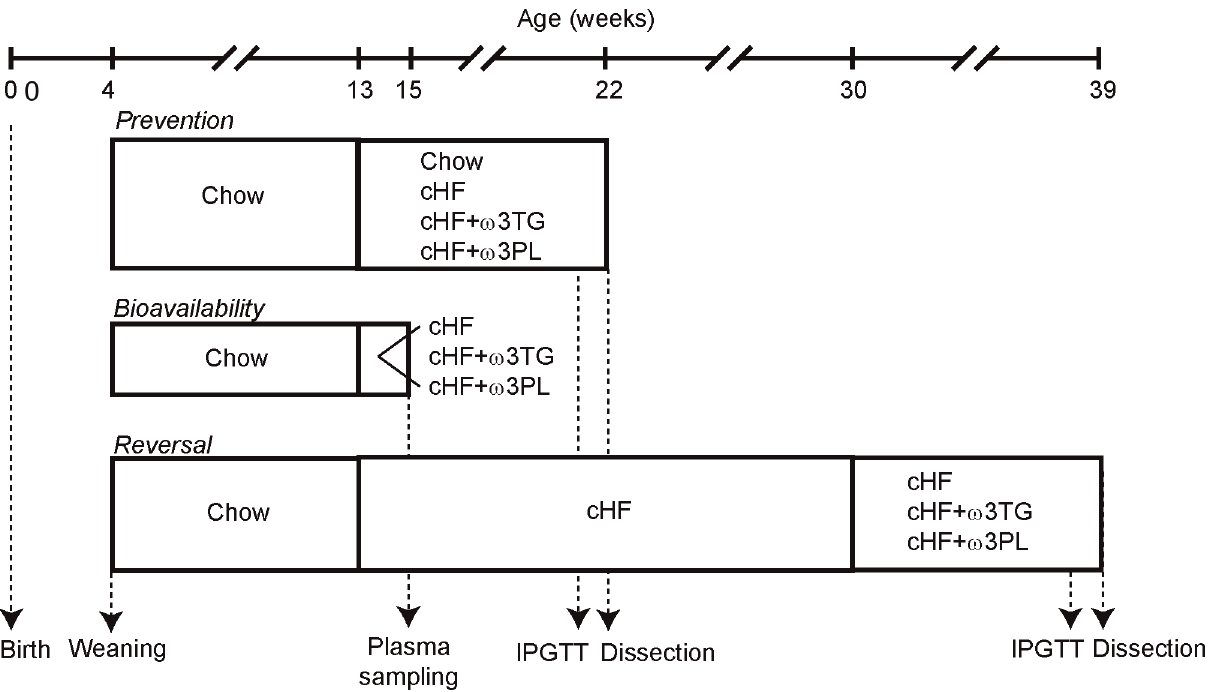
Figure 1. Timeline of dietary studies. All mice were weaned on Chow diet at 4 weeks of age. In the ‘prevention’ and ‘bioavailability’ studies, 3- month-old mice were switched from Chow to cHF, cHF + v 3TG and cHF + v 3PL diets for a period of 2 or 9 weeks, respectively, as indicated. In the ‘reversal study’, mice were fed cHF diet for a period of 4 month, followed by 9-week-feeding using cHF, cHF + v 3TG and cHF + v 3PL diets. In the ‘bioavailability’ study, cHF + v 3TG and cHF + v 3PL diets with several different concentrations of DHA and EPA were used (see Methods and Figure 2A,B), while in the ‘prevention’ and ‘reversal’ studies these diets were matched for their DHA/EPA content (i.e. 30 g DHA/EPA per kg diet), except for the ‘prevention’ study, in which a subgroup of mice was also treated using cHF + v 3PL diet containing 10 g DHA/EPA per kg diet. See Methods for further details. IPGTT, intraperitoneal ( i.p. ) glucose tolerance tests.